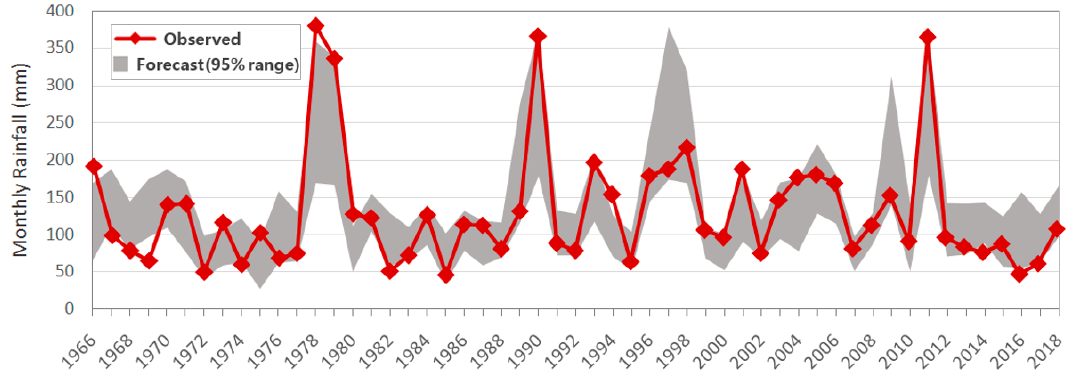
Figure 6. 95% prediction uncertainty interval of the monthly rainfall in June.